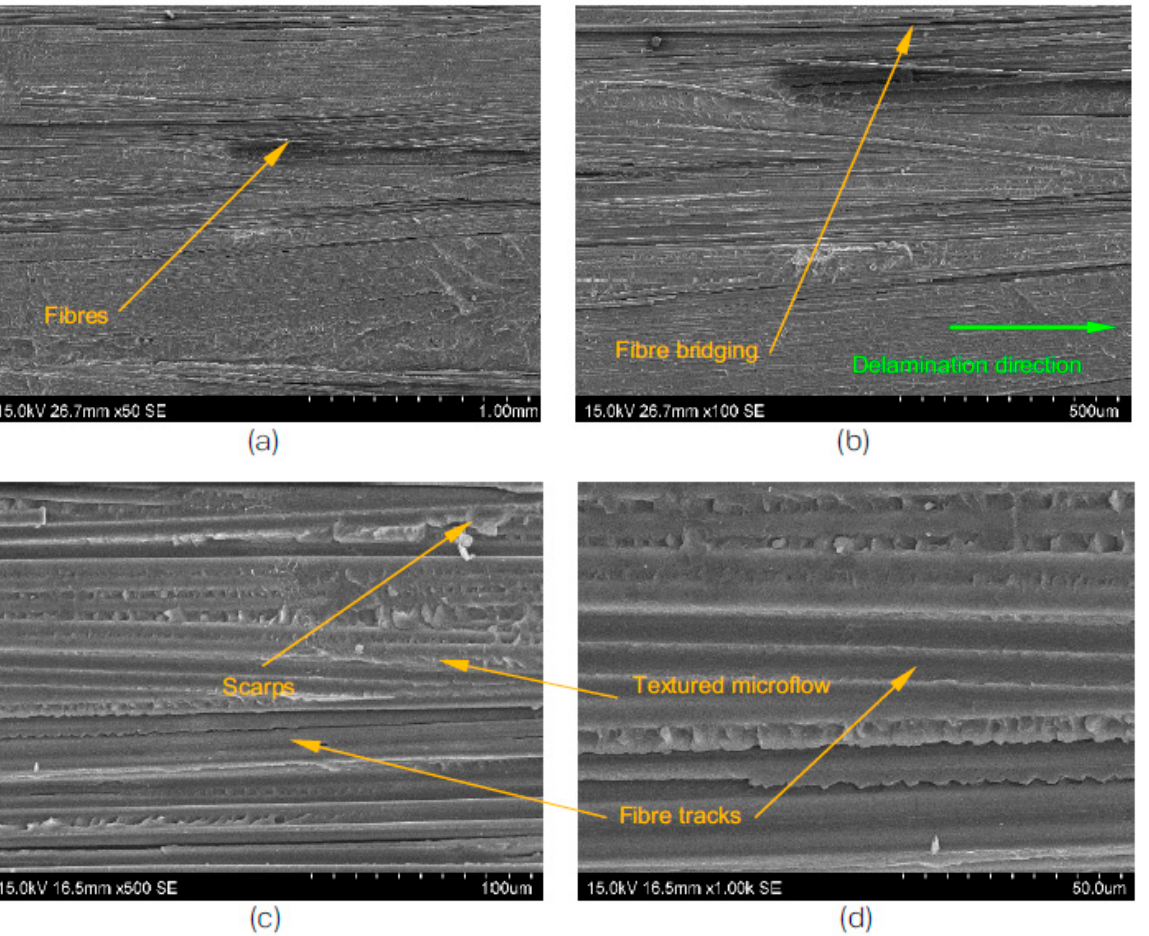
Figure 8. SEM view of the T700/PA6.6 DCB specimens after the test; scale bar is ( a ) 1 mm, ( b ) 500 µm, ( c ) 100 µm, and ( d ) 50 µm.